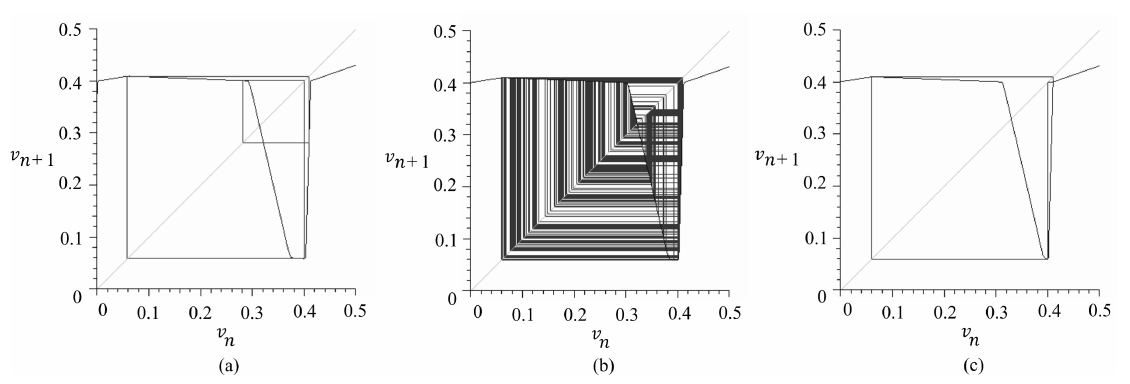
Figure 20. Iterative paths with the initial point: v 0 = 0.5. ( a ) E = 0.44. ( b ) E = 0.445. ( c ) E =